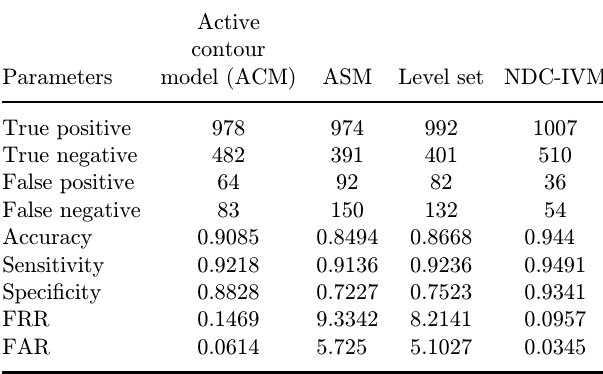
Table 3. Comparison between existing and proposed techniques.